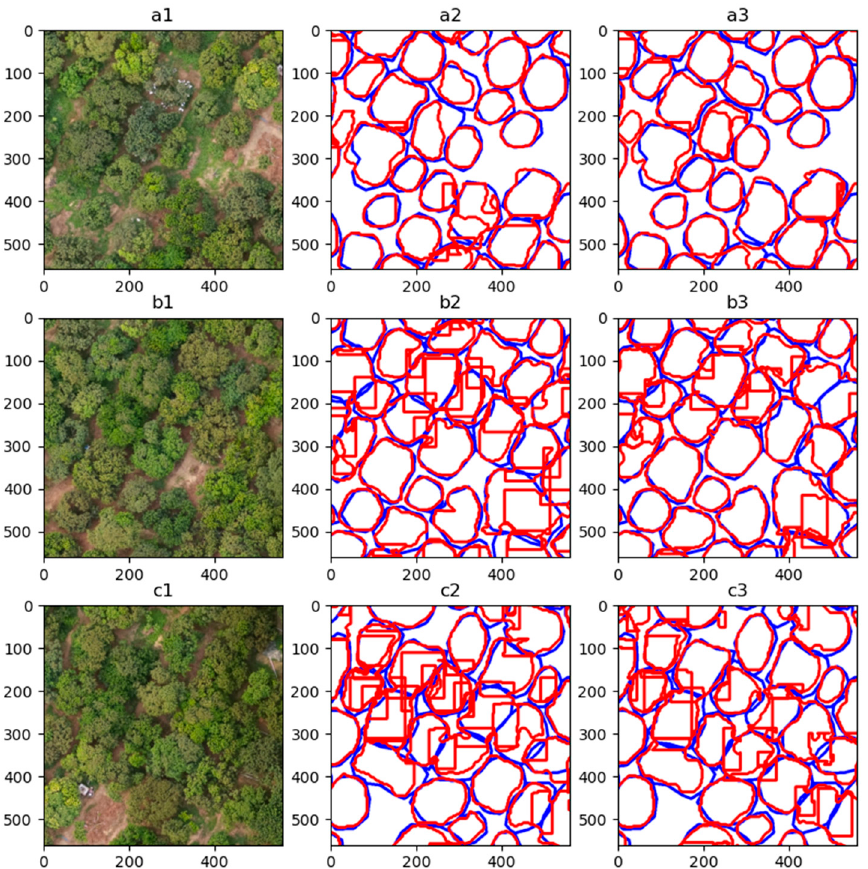
Figure 10. Enlarged display of the models’ inference results. Rows a to c: three areas selected in Area B. Column 1: DOM of each area selected. Columns 2 and 3: the inference results from the model with default and best configuration respectively. The meaning of the line colors in Columns 2 and 3 is consistent with Figure 9.